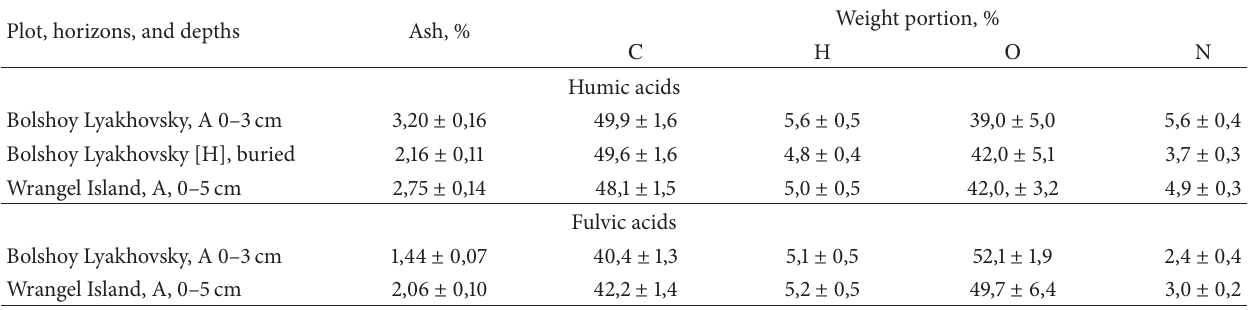
Table 2: Elemental composition of HAs and FAs (all results are given for ash-free preparations). Weight portion, % Plot, horizons, and depths Ash, % b H \ N Humic acids